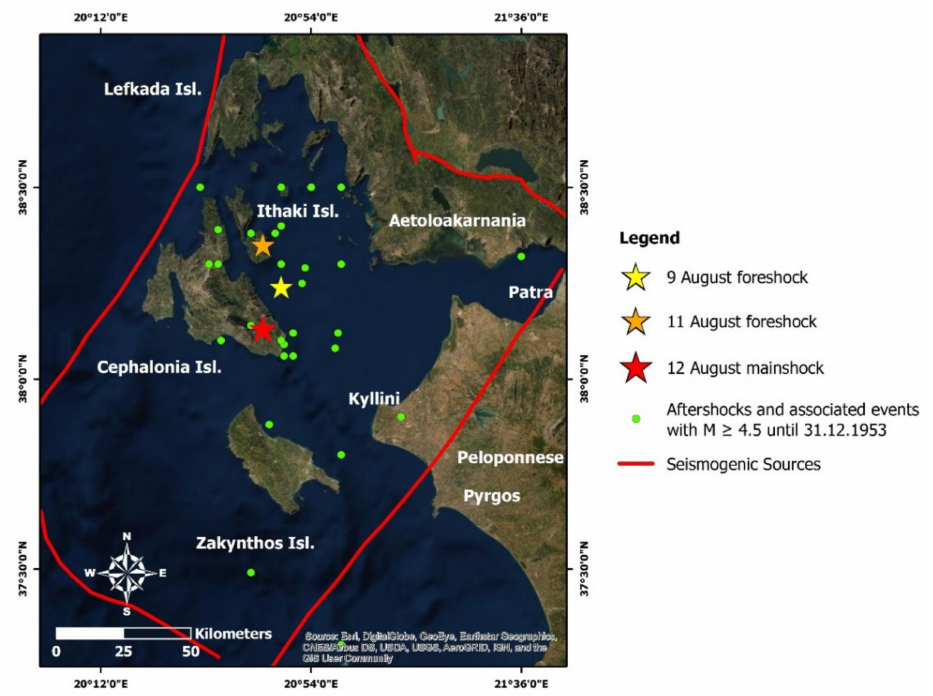
Figure 3. The epicenters of the 12 August 1953 (red star) along with the foreshocks on 9 August (yellow star) and on 11 August (orange star) and the aftershocks and associated events until the end of December 1953 (green circles) based on the earthquake catalogue of Makropoulos et al. [25]. Seismogenic sources are also presented based on the Greek Database of Seismogenic Sources by Caputo et al. [38]. The Cephalonia Transform Fault Zone is located offshore west of Lefkada and Cephalonia